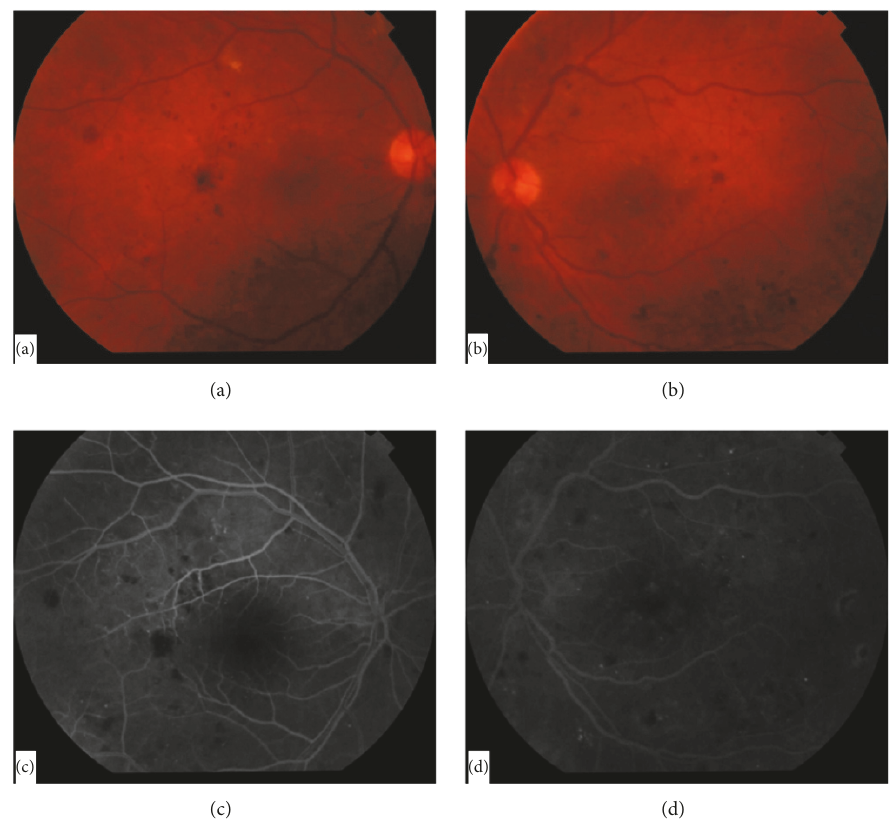
Figure 1: Fundus photography and fluorescein angiography of both eyes. Fundus photography showed retinal hemorrhages affecting the posterior pole in both eyes with clinically significant macular edema in the left eye (a and b). Fluorescein angiography revealed microaneurysms and areas of blocked fluorescence due to retinal hemorrhages in both eyes with leakage of fluorescein in the left macula (c and